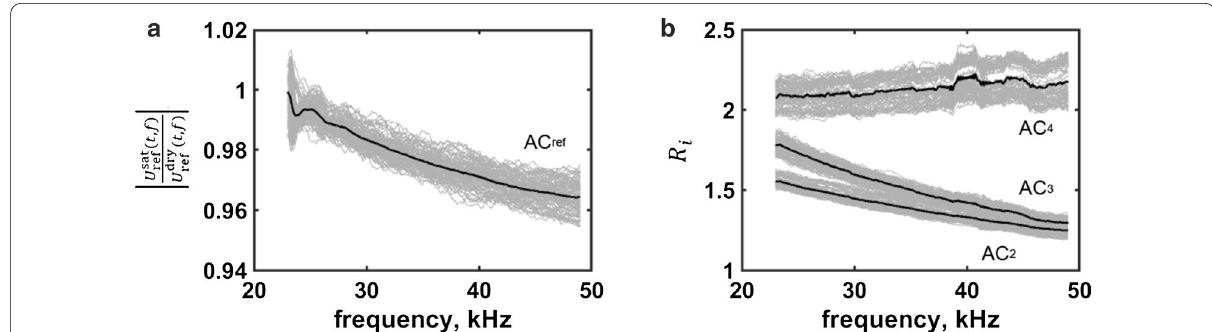
Fig. 8 Spectral amplitude ratios between dry and nearly saturated conditions. See “Monitoring capability for water content change in our system” section for definitions of a (cid:31)